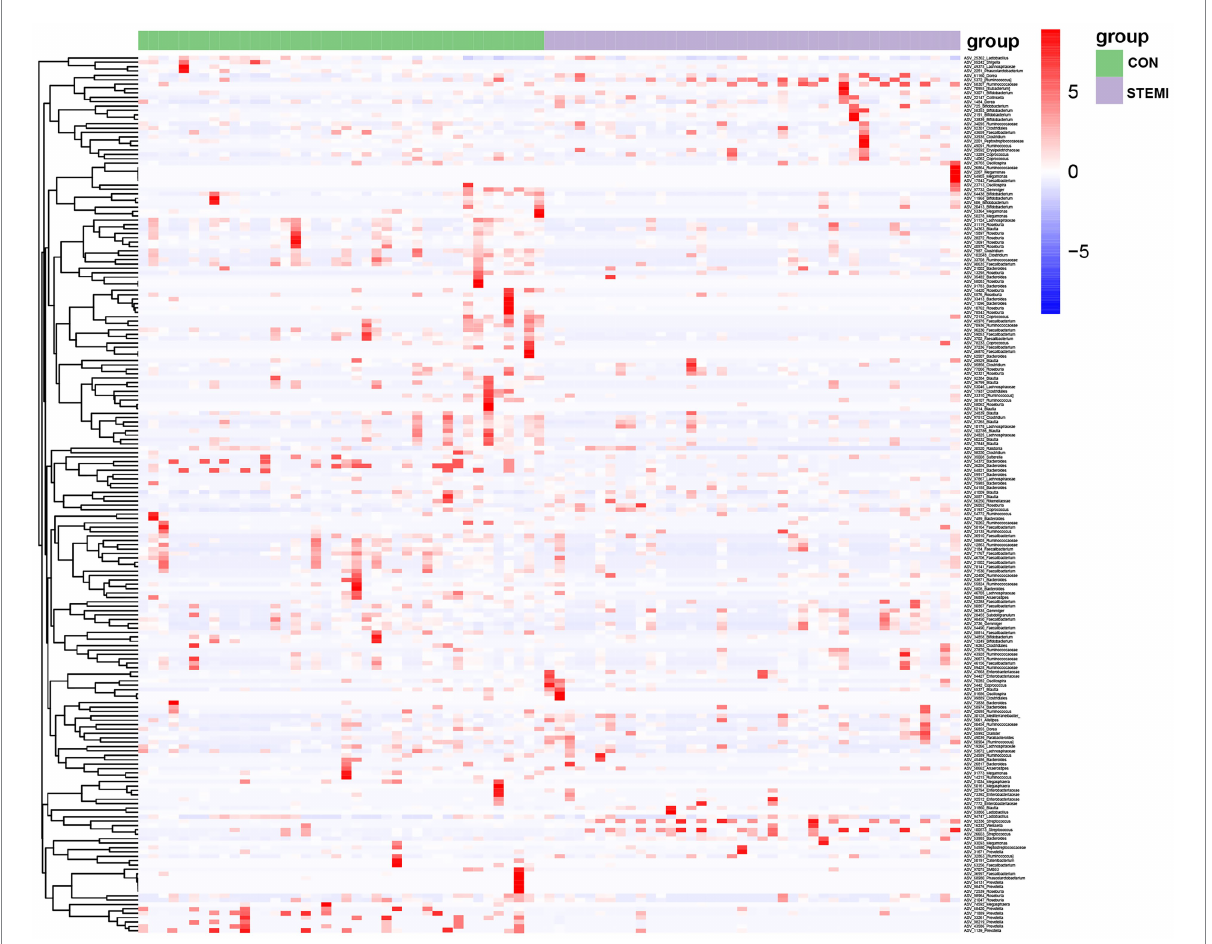
FIGURE 3 Heatmap of the correlations between the top 200 most abundant ASVs (hierarchically